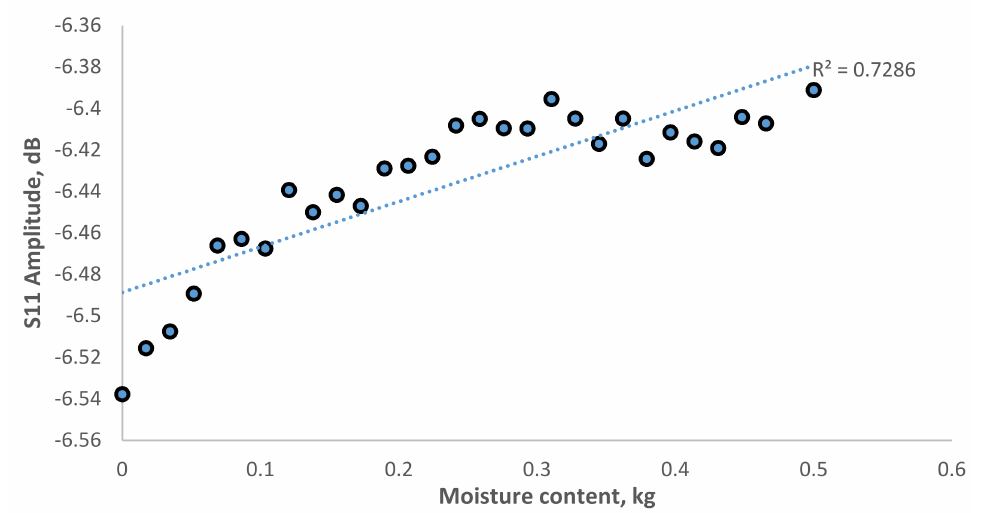
Figure 9. Correlation of S11 amplitude against moisture content in Europe EN 206-1-2013 correlation in 2.43